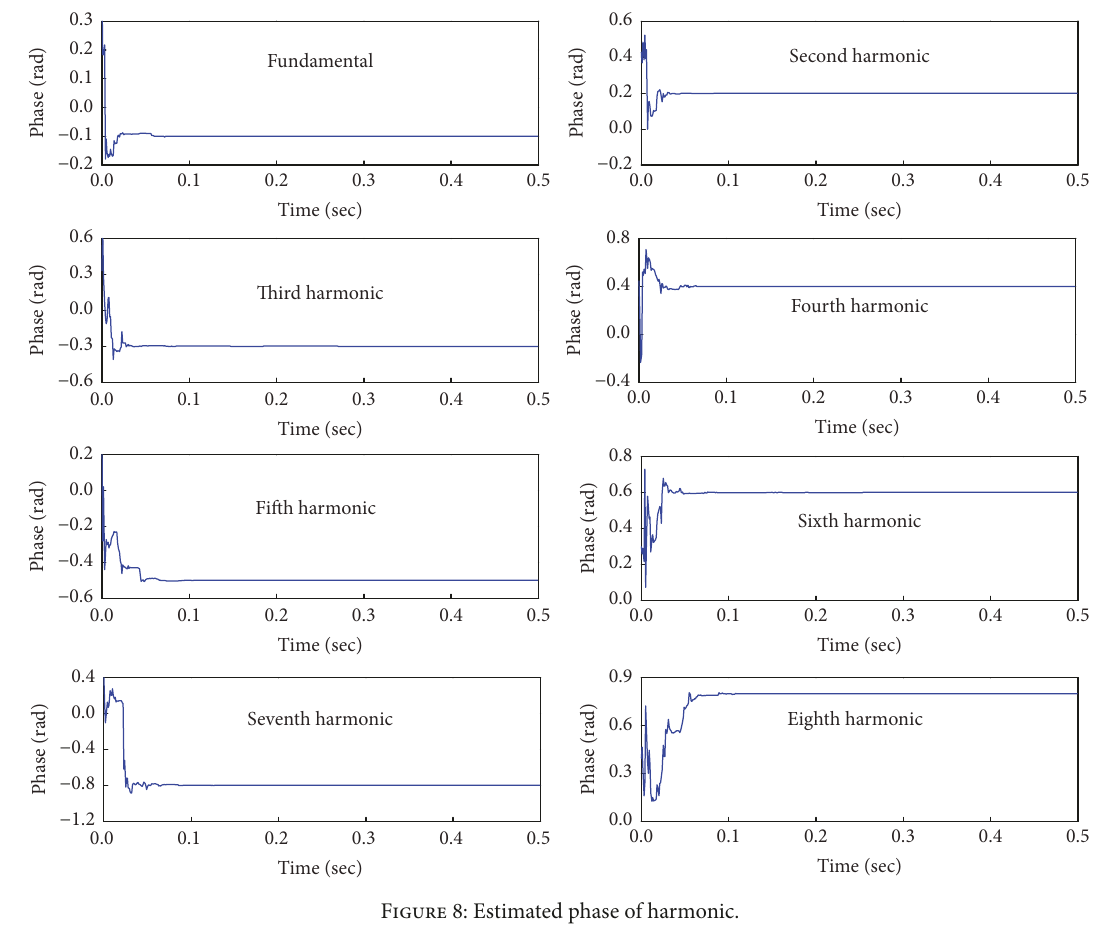
Figure 8: Estimated phase of harmonic.